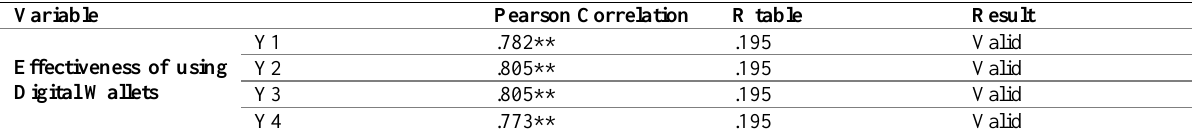
Table 6: Validity Test Results Effectiveness of using Digital Wallets